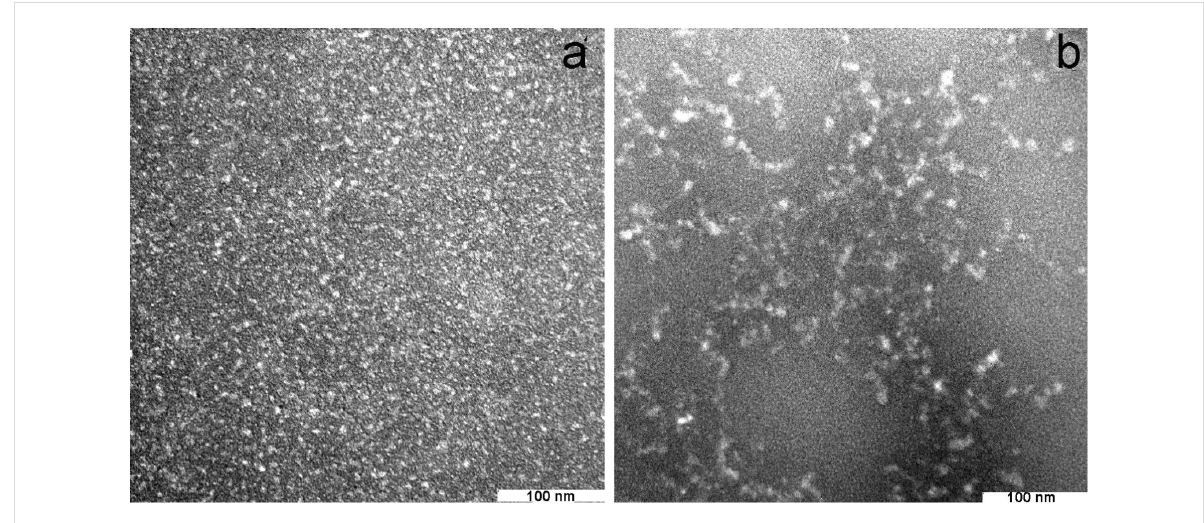
Figure 3: TEM images of Si–NH 2 (a) nanoparticles and Si–NH 2 ·ODN(1) nanocomplexes (b).